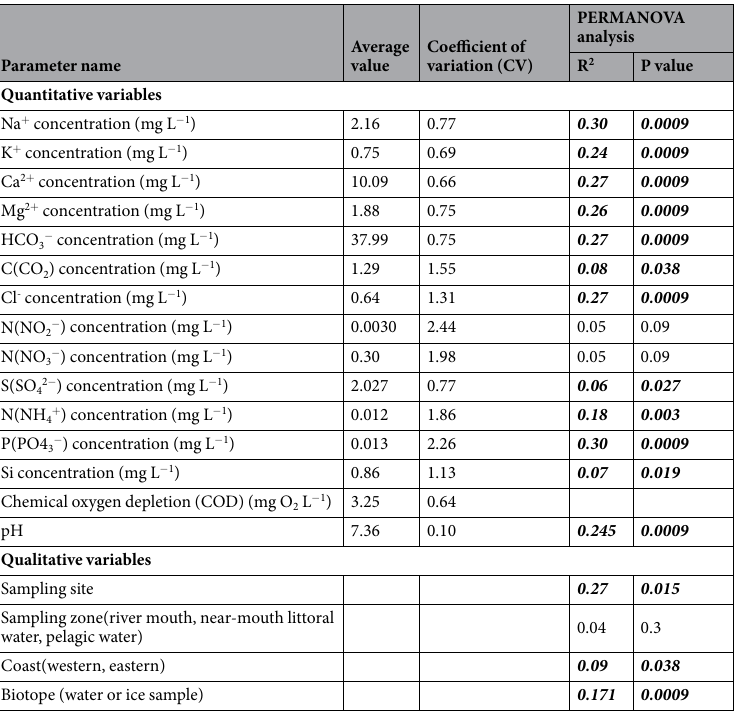
Table 1. PERMANOVA analysis results for the assessing the statistical significance of the influence of hydrochemical parameters in sampling sites on the complex of biological